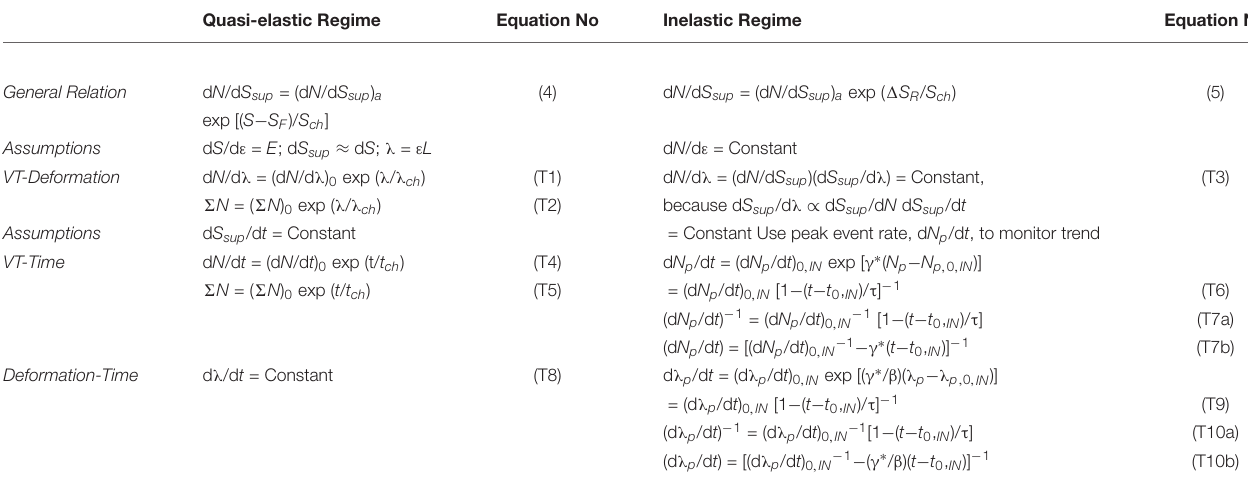
TABLE 1 | Regimes for elastic-brittle precursors to